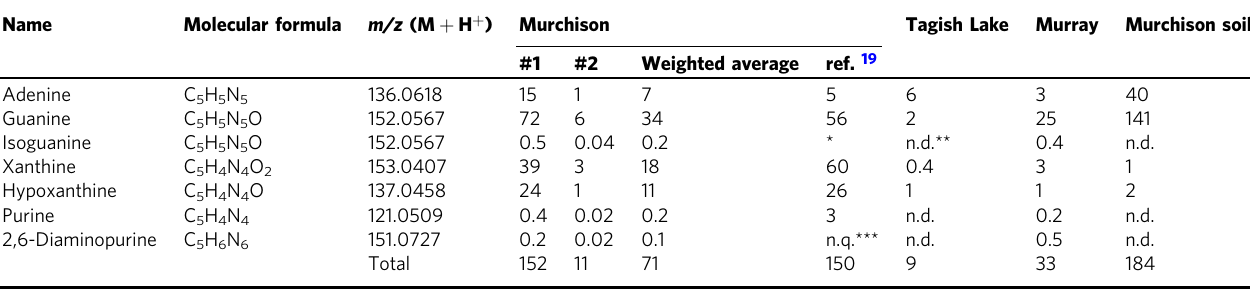
Table 1 Variations in the concentration (in ppb) of purine nucleobases and their analogs in the meteorite extracts and Murchison